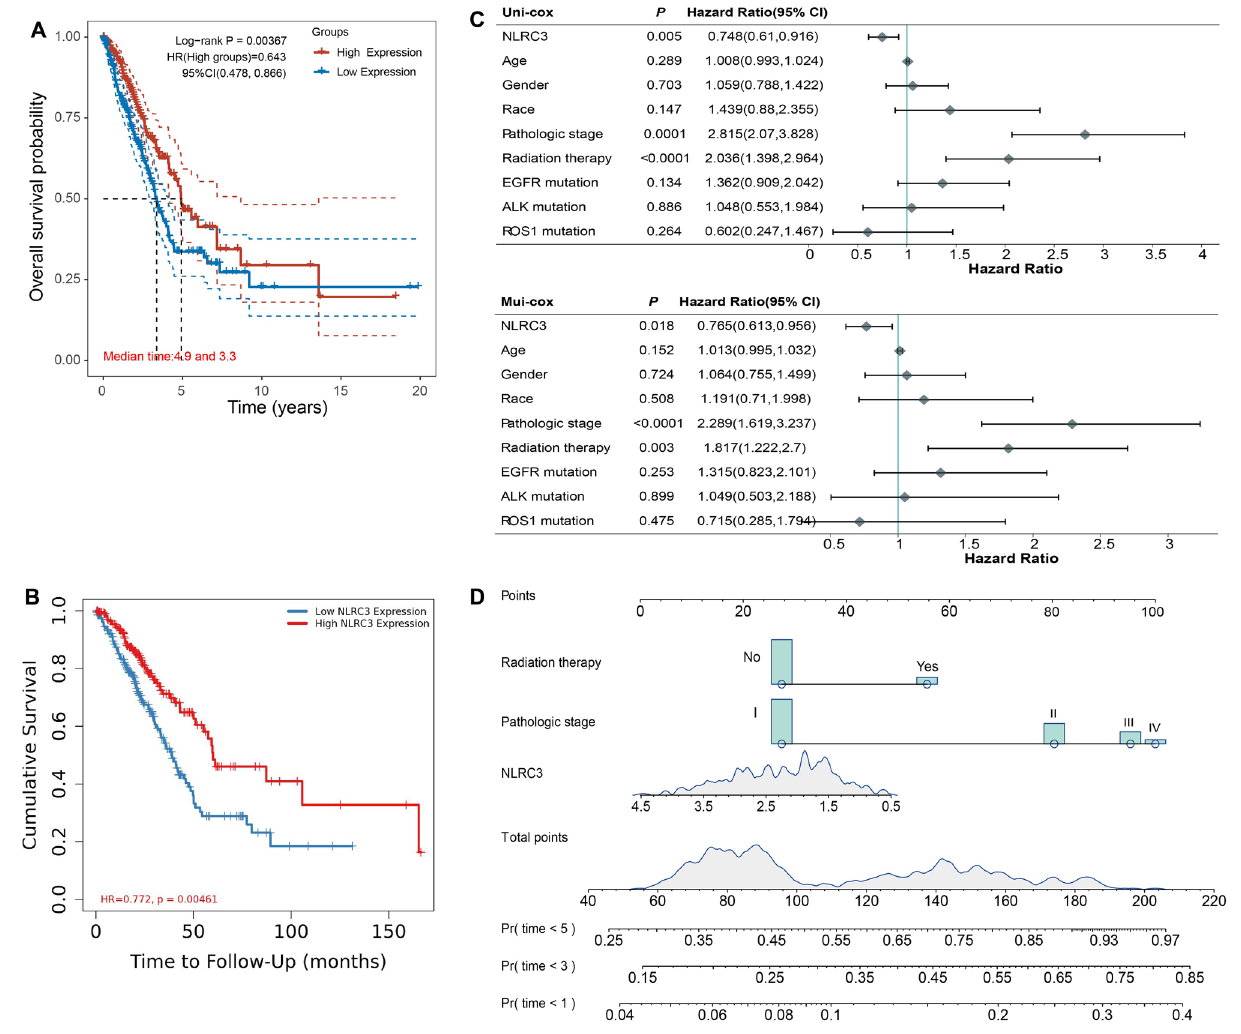
Figure 2. NLRC3 was associated with improved survival and was an independent prognostic factor in LUAD. ( A ) Overall survival (OS) of patients with LUAD grouped according to the median NLRC3 expression level. Analysis was performed using the software R version 4.0.3. ( B ) OS of patients with LUAD grouped according to the median NLRC3 expression level from TIMER2.0. ( C ) Results from univariable and multivariable regression analyses of prognostic factors for OS. Analysis was performed using the software R version 4.1.1. ( D ) Nomogram for predicting 1-, 3-, and 5-year survival rates in patients with LUAD. Analysis was performed using the software R version